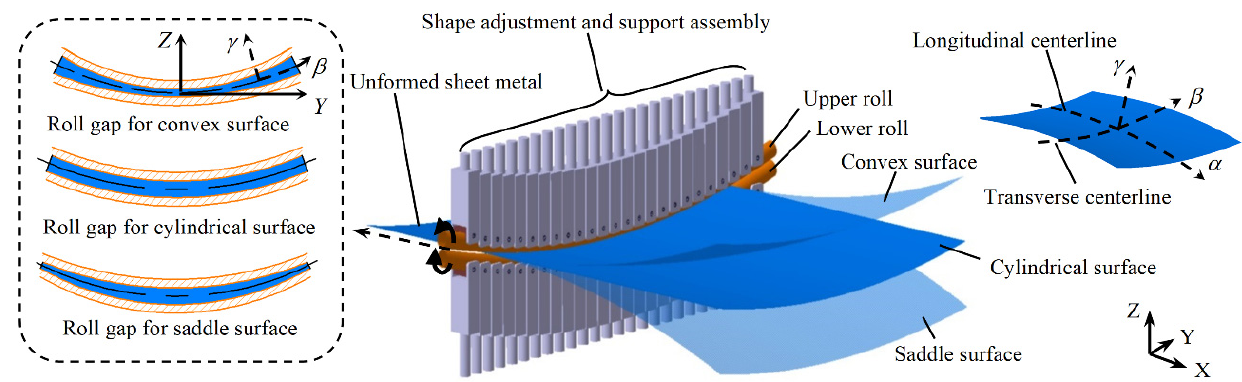
Figure 2. Schematic diagram of continuous roll forming.